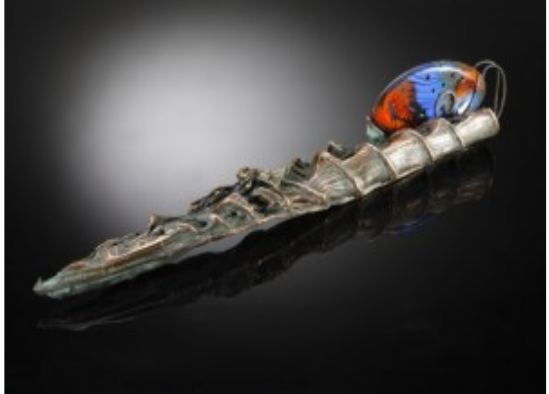
Figure 5. Keith Cummings; Pennant, 1998; glass and bronze, bronze applied to wax model, wax steamed out and glass cast into mould; photo credit: Simon Bruntnell, used with permission. Arts 2020 , 9 , x FOR PEER REVIEW